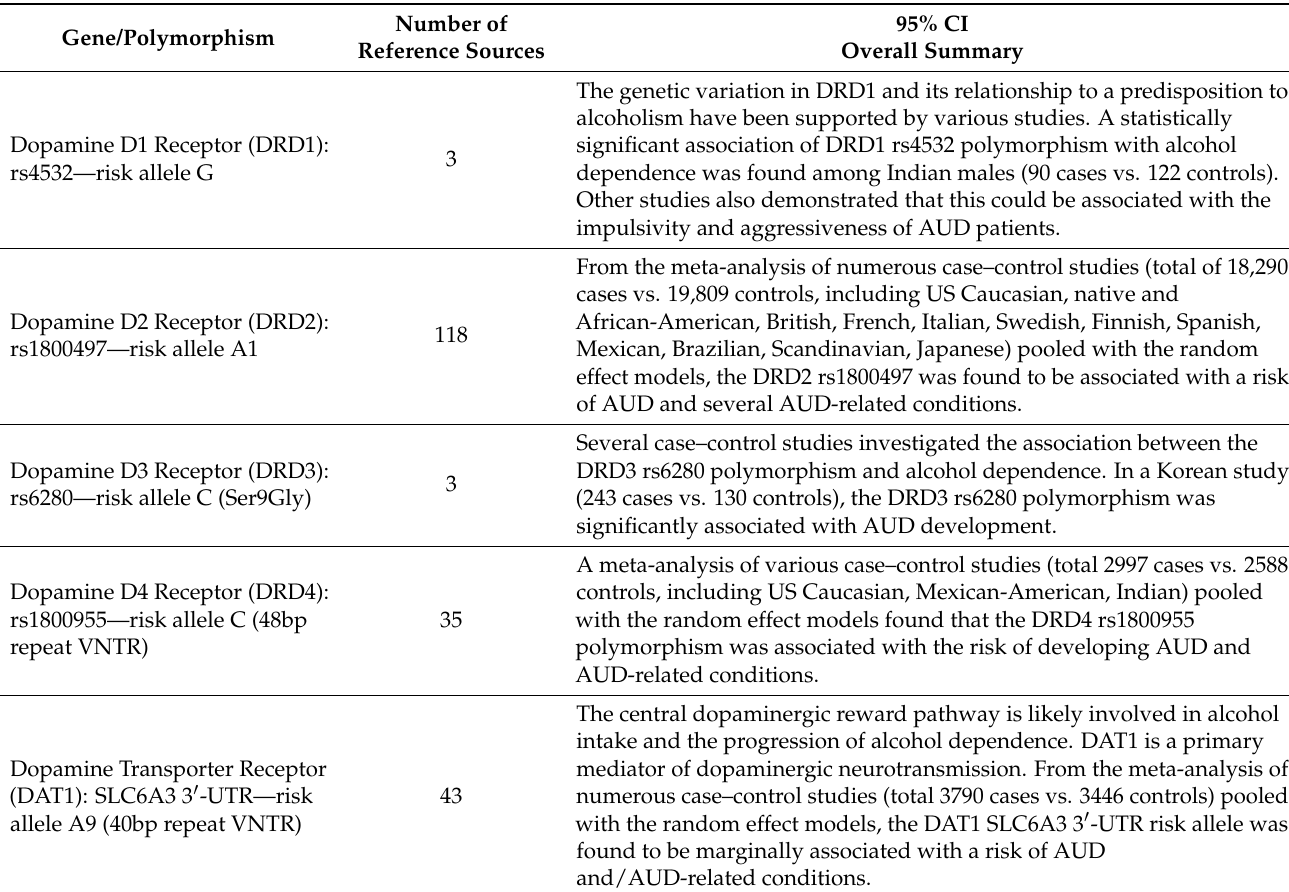
Table 1. Gene polymorphisms under consideration and the literature